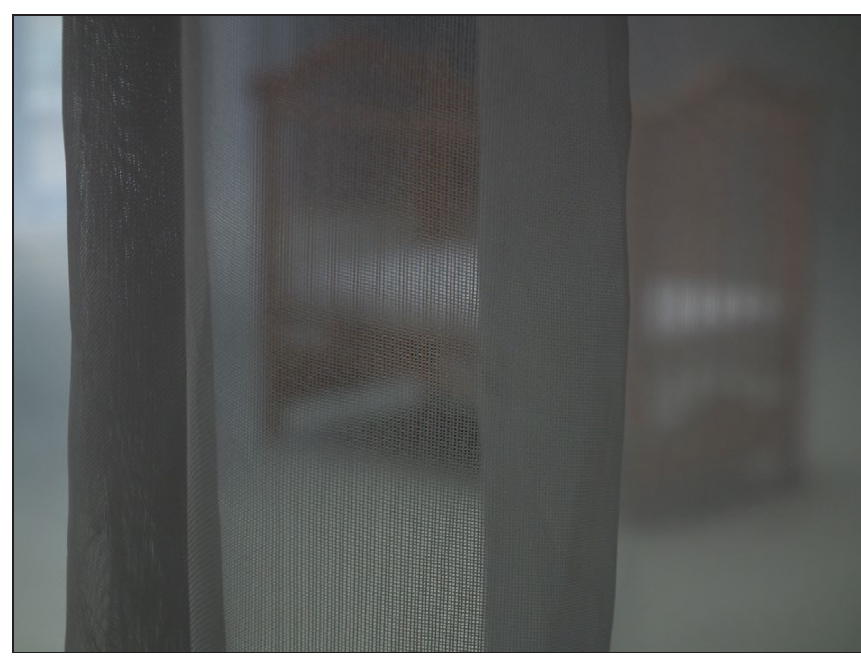
Figure 5: Elena Marchevska ‘‘ The place where we were last together ’’ 2011,